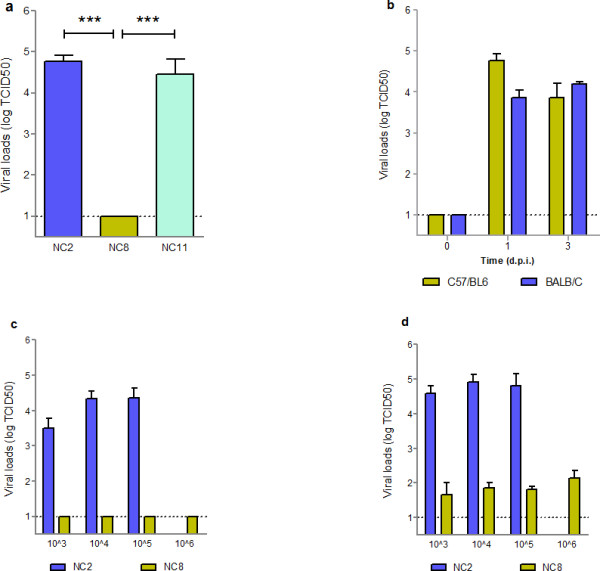
Heterogonous viral replication of pandemic influenza H1N1 strains in mice lungs. (a) Viral loads in the lungs of NC2, NC8 and NC11 infected C57/BL6 mice were determined at 1 d.p.i.. (b) Viral loads NC2 were also examined in C57/BL6 and BALB/C mice (n =3). Replication kinetics of NC2 and NC8 were compared in BALB/C mice infected with dose series of viruses at (c) 1 d.p.i. and (d) 3 d.p.i.. MDCK cells were used to determine viral loads in serially diluted lung homogenates collected at different time intervals. Results are presented as mean ± SEM of TCID50. Statistical differences were calculated by Mann Whitney U test. *** - P < 0.0001.